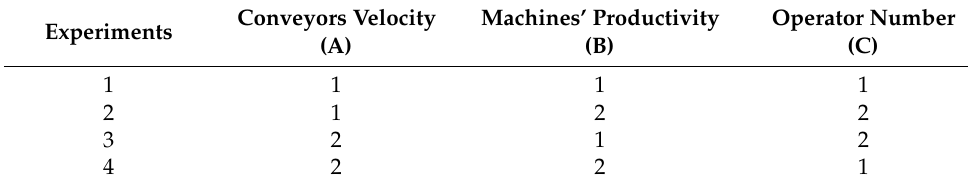
Table 8. Orthogonal Array (OA) L4 (2 3 ). Experiments